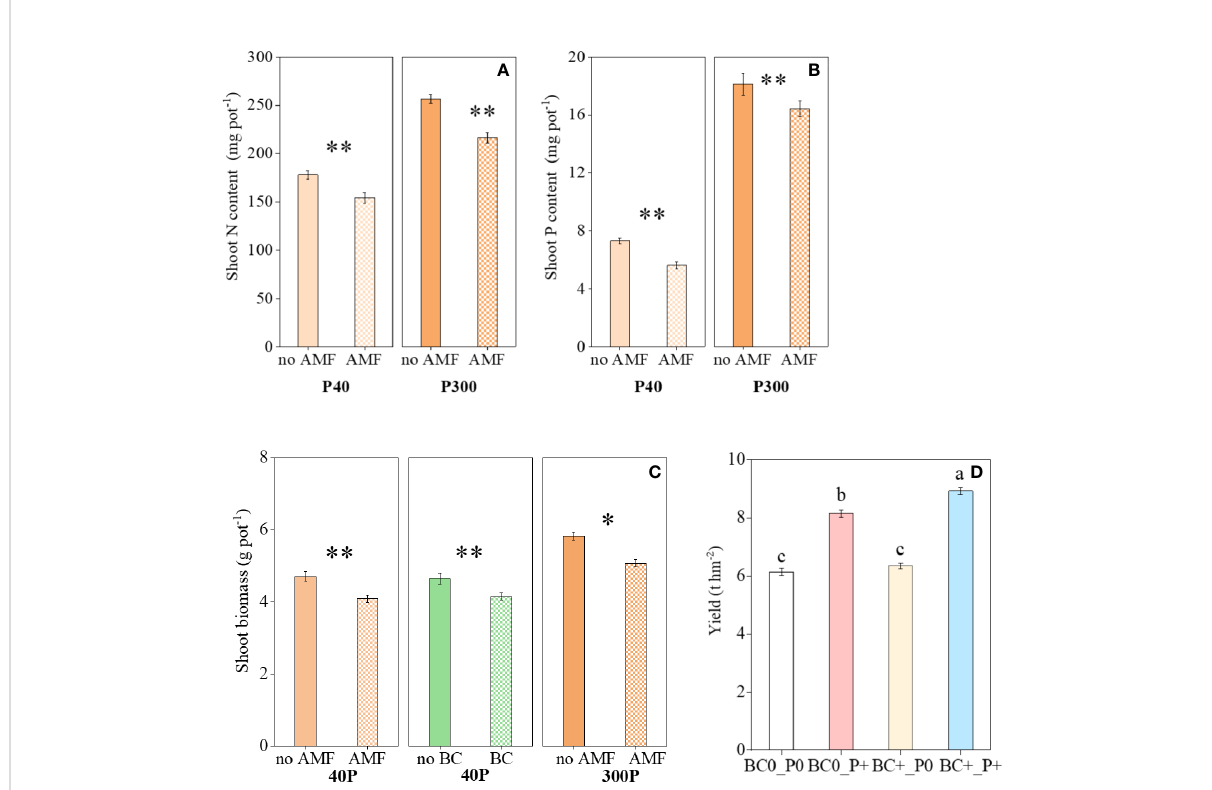
FIGURE 1 Variation in the (A) shoot N content, (B) shoot P content and (C) shoot biomass as in fl uenced by P rates (40 and 300 mg kg − 1 soil) and AMF and BC additions in the greenhouse experiment. Each value is the mean of fi ve replicates (±SE). (D) Variation in wheat yield in fi eld experiment. Each value is the mean of four replicates (±SE). * P ≤ 0.05 and ** P <